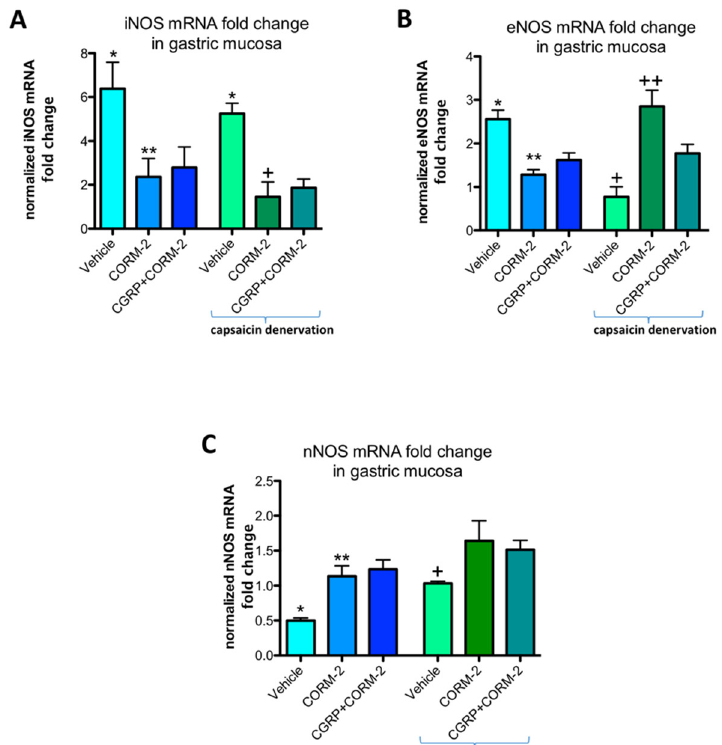
Figure 8. iNOS ( A ), eNOS ( B ), and nNOS ( C ) mRNA fold change in gastric mucosa of rats with or without capsaicin denervation and pretreated with vehicle or CORM‐2 (5 mg/kg i.g.) alone or with CGRP‐α (10 µg/kg i.p.) followed by i.g. administration of 75% ethanol. Results are expressed as mRNA fold change of iNOS, eNOS, and nNOS normalized to succinate dehydrogenase complex, subunit A (SDHA) and β‐actin. Results are mean ± SEM of 4–5 rats per each experimental group. ( A ) Asterisk indicates significant change as compared with intact rats ( p < 0.05); double asterisks indicate significant difference as compared with vehicle pretreated group without capsaicin denervation ( p < 0.05); cross indicates significant change as compared with vehicle pretreated group with capsaicin denervation ( p < 0.05); ( B ) Asterisk indicates significant change as compared with intact rats ( p < 0.05); double asterisks indicate significant difference as compared with vehicle pretreated group without capsaicin denervation ( p < 0.05); cross indicates significant change as compared with vehicle pretreated group without capsaicin denervation ( p < 0.05); double crosses indicate significant difference as compared with vehicle pretreated group with capsaicin denervation ( p < 0.05); ( C ) Asterisk indicates significant change as compared with intact rats ( p < 0.05); double asterisks or cross indicates significant difference as compared with vehicle pretreated group without capsaicin denervation ( p < 0.05).